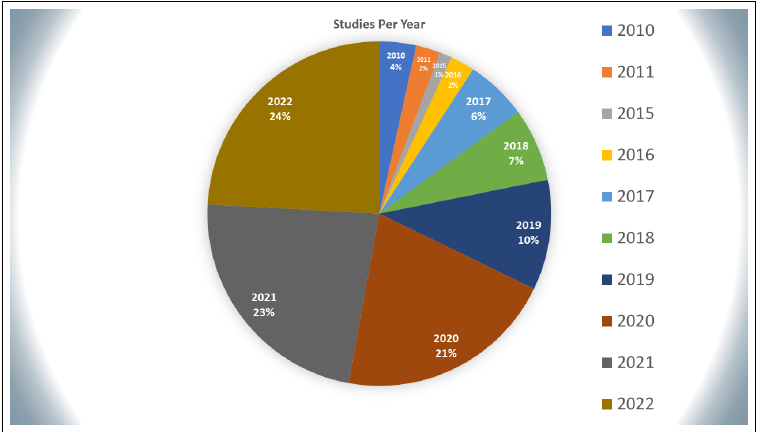
Figure 4. Distribution of studies per